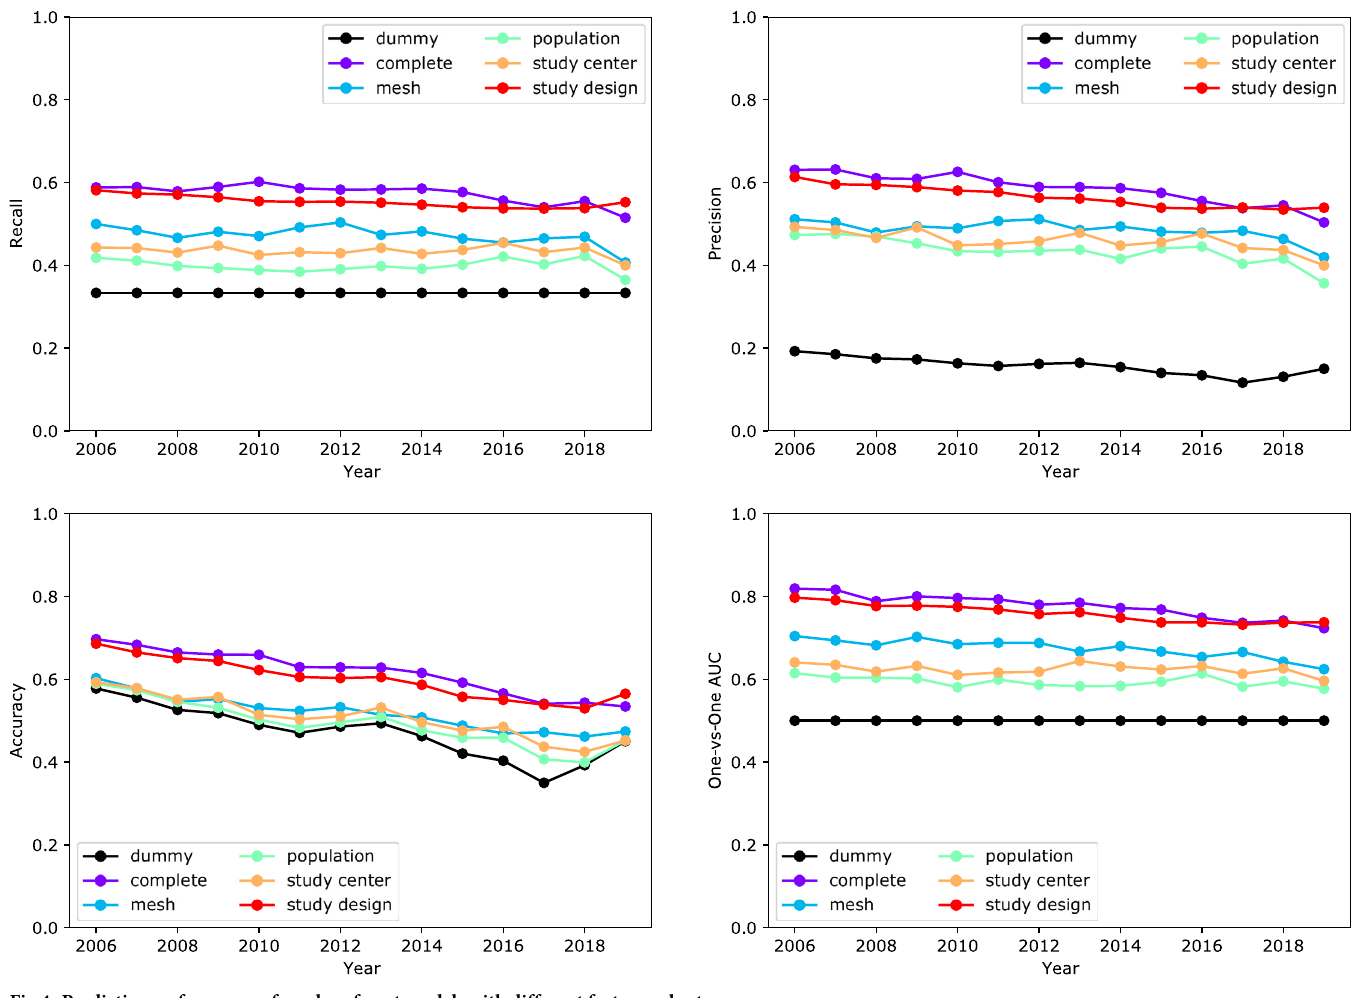
Fig 4. Predictive performance of random forest models with different feature